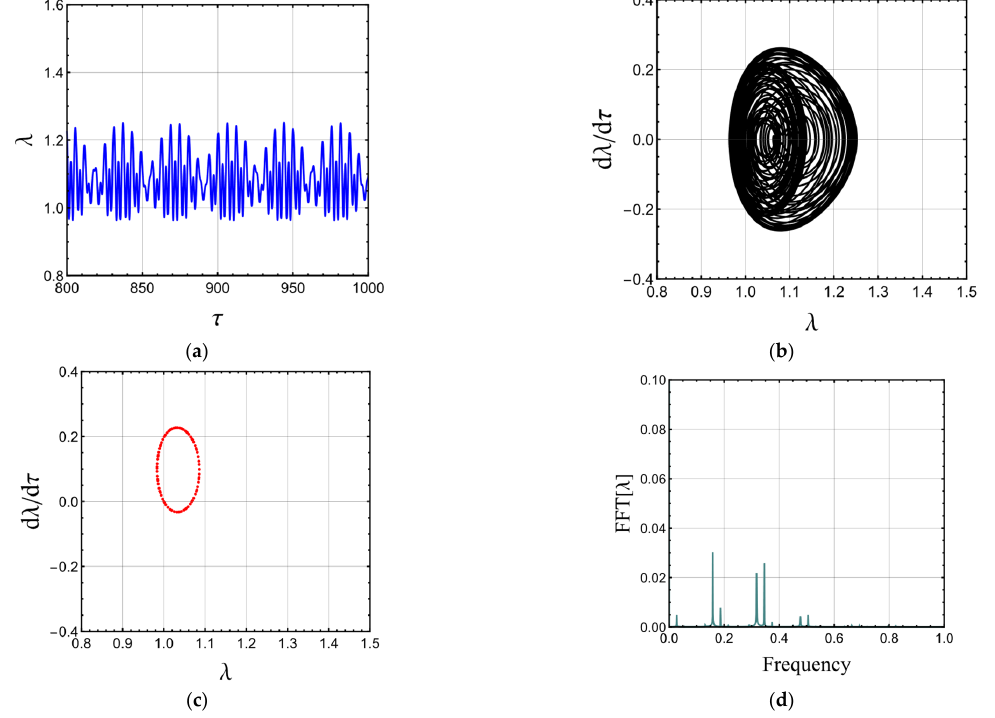
Figure 7. The dynamic response of the electro-magneto-active polymer to time-varying voltage H = H S = 0.4and K = 0.3. ( a ) Time history, ( b ) phase plane diagram, ( c ) Poincar é map, and ( d ) FFT.